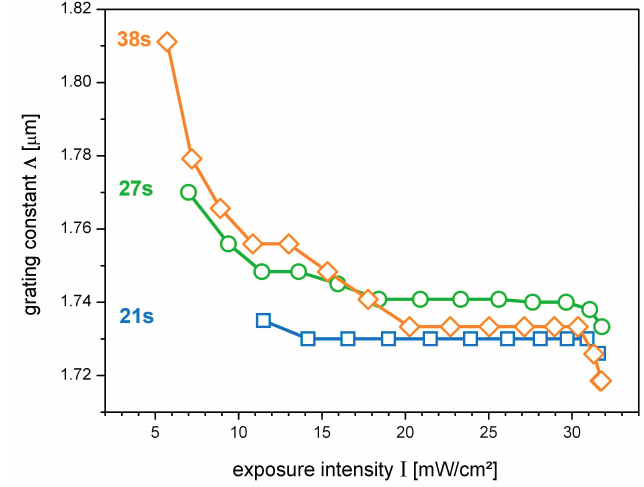
Figure 1. Lateral progressions of the grating constant Λ ( I ), derived from lateral scans. The longer the exposure duration, the more Λ decreases towards the centre of the grating. The period is almost constant for t exp = 21 s (blue squares), while in case of t exp = 27 s (green circles) and t exp = 38 s (orange diamonds) a more and more intensity-dependent behavior